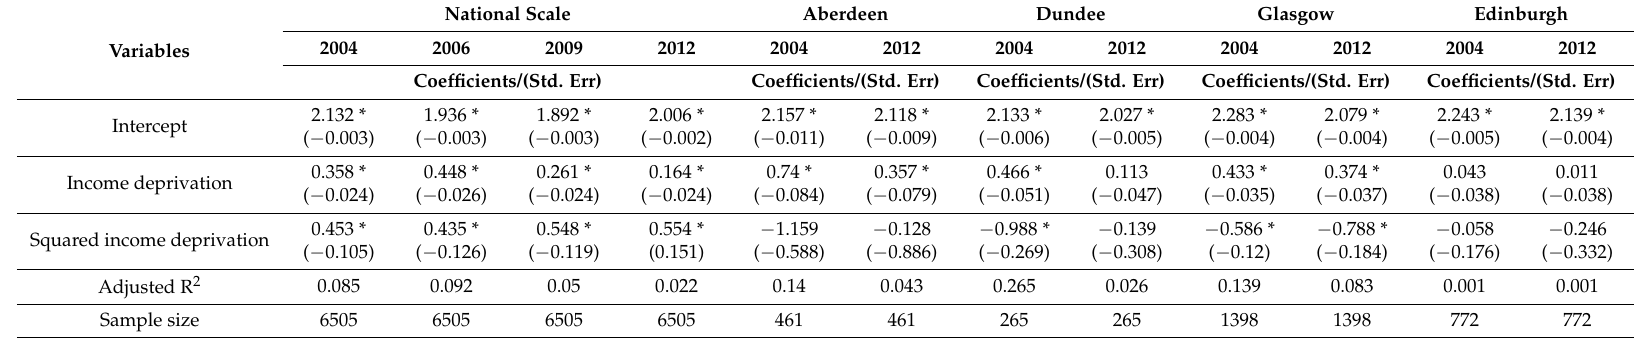
Note. The symbol “*” represents the significance level at